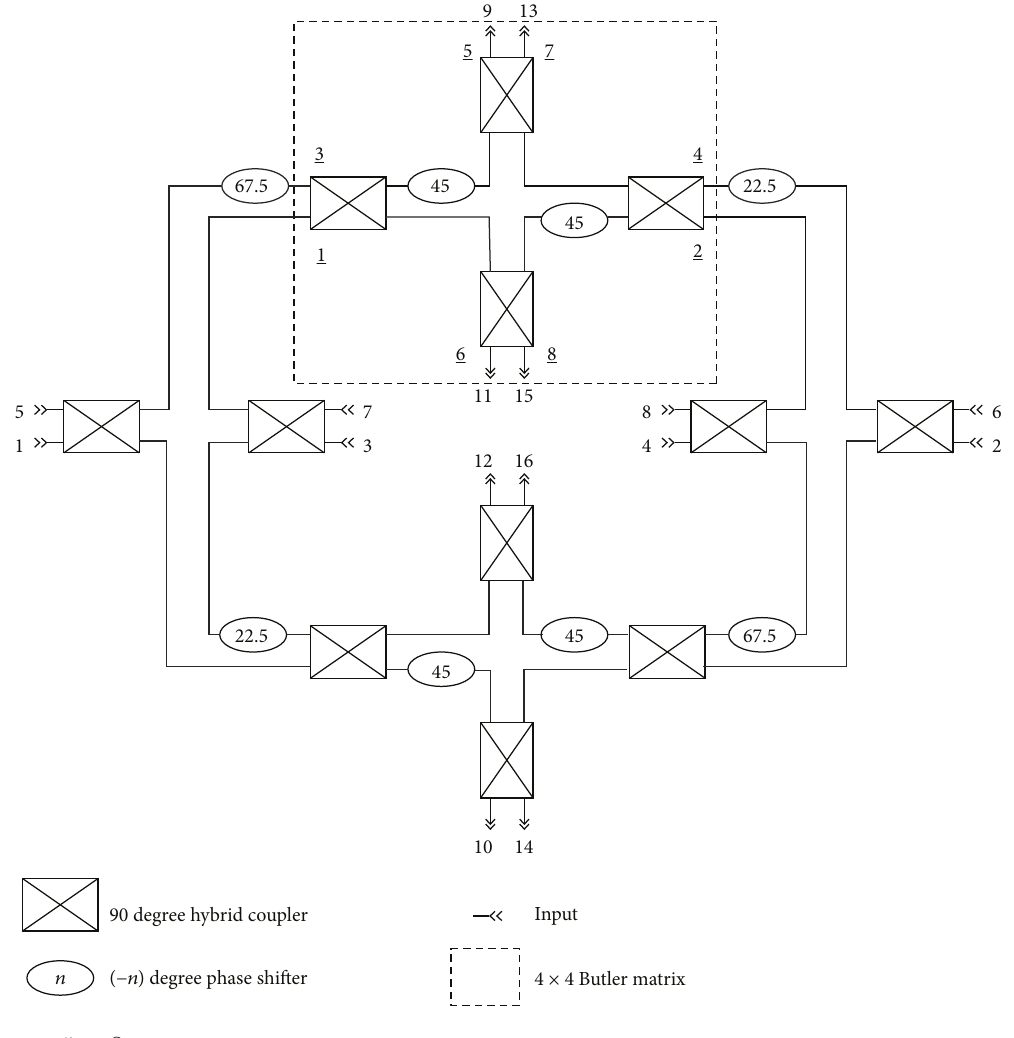
Figure 1: Topologies of the 4 × 4 and the 8 × 8 BMs. i , and beam